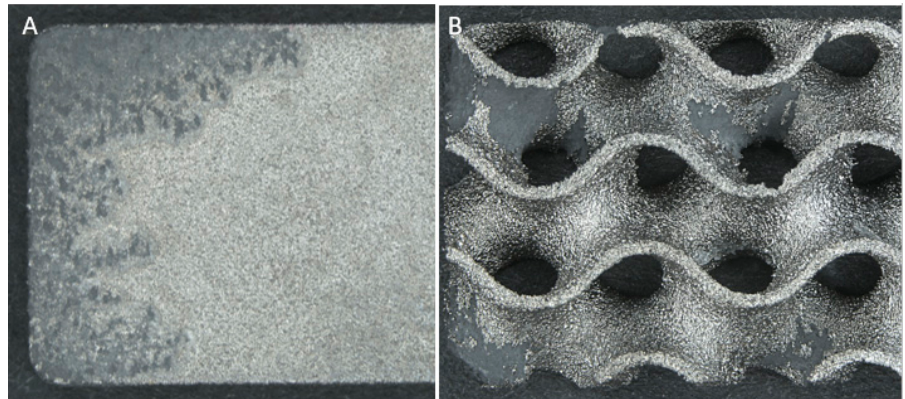
Figure 6. Stereozoom comparison of spread and interconnected finger-like propagations of corrosion on a ( A ) Ti6Al4V solid sample and isolated patches on a ( B ) 80% porous Ti6Al4V gyroid sample produced by LPBF. Table 5. Corrosion spread analysis, percentage and surface area that experienced corrosion. ** Denotes statistical significance to solid samples p < 0.05 (One-way ANOVA, Tukey).